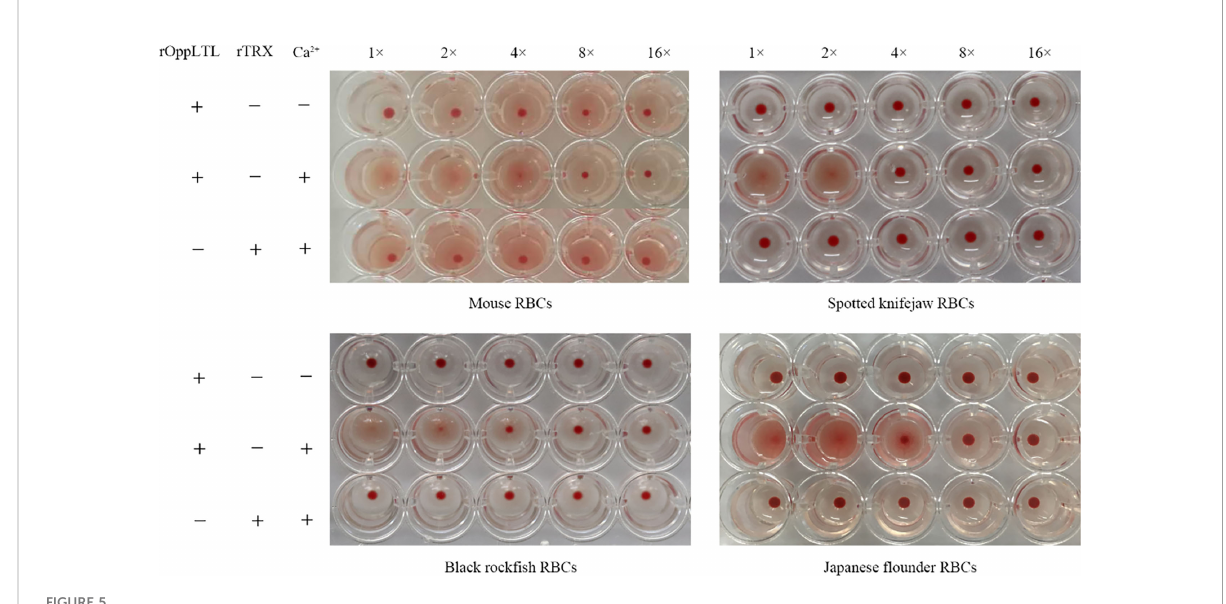
FIGURE 5 Agglutination activity of rOppLTL to red blood cells (RBCs). RBCs from mouse, spotted knifejaw, Japanese fl ounder, and black rock fi sh were incubated with rOppLTL and rTrx. The mixture was placed at room temperature for 1 h. "-" and "+" represent the absence and presence of rOppLTL, rTRX, and Ca2+, respectively.